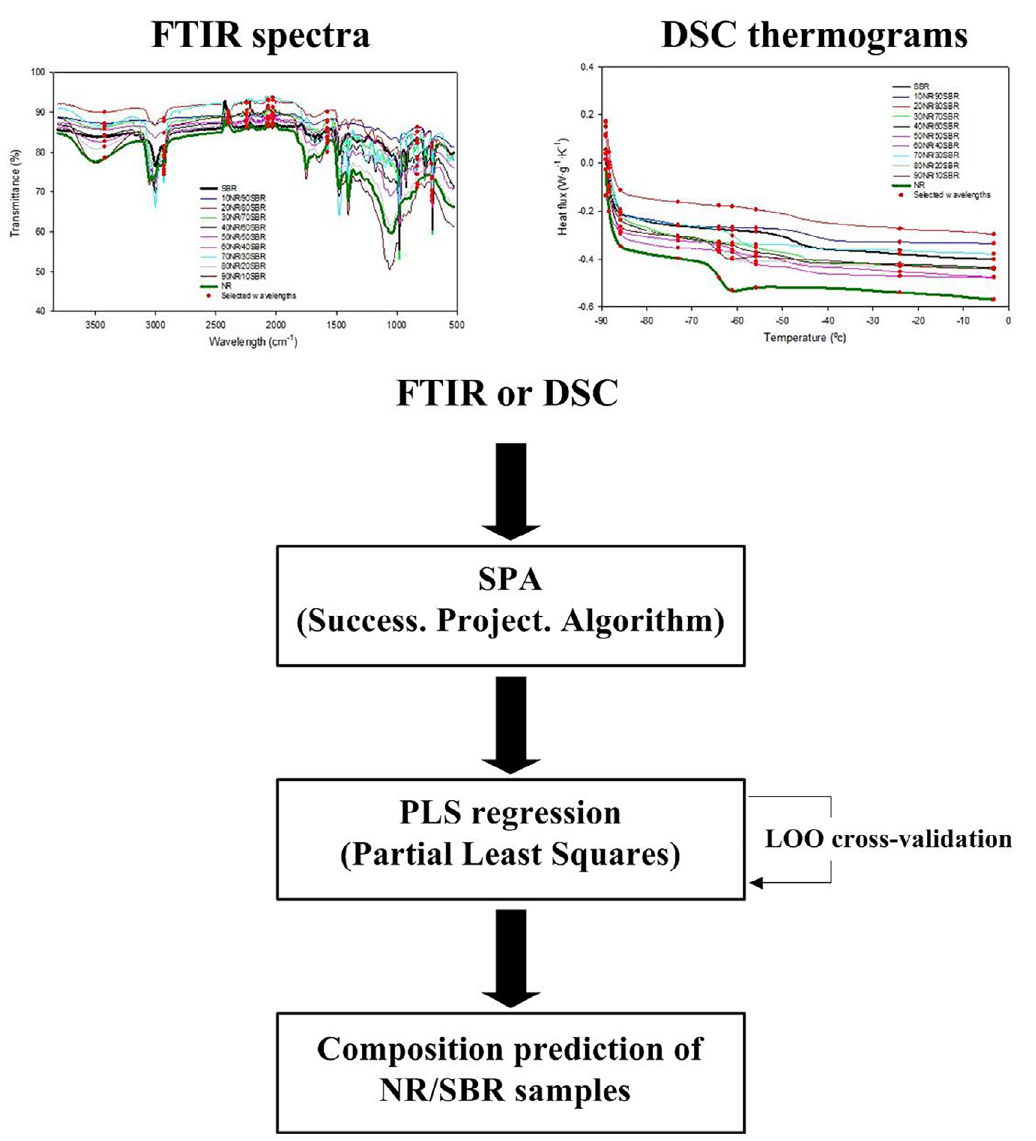
Figure 1. Flowchart summarizing the mathematical methods applied in this